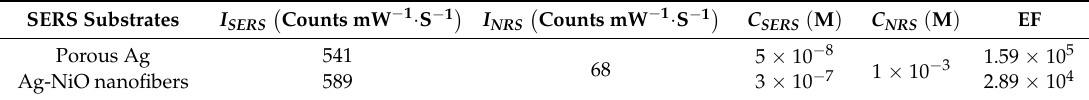
Table 2. Values of measured (cid:1835) (cid:3020)(cid:3006)(cid:3019)(cid:3020) and (cid:1835) (cid:3015)(cid:3019)(cid:3020) on porous Ag and Ag-NiO nanofibers, as well as (cid:1840) (cid:3020)(cid:3006)(cid:3019)(cid:3020) Table 2. Values of measured I SERS and I NRS on porous Ag and Ag-NiO nanofibers, as well as N SERS and (cid:1840) (cid:3015)(cid:3019)(cid:3020) . and N NRS . SERS